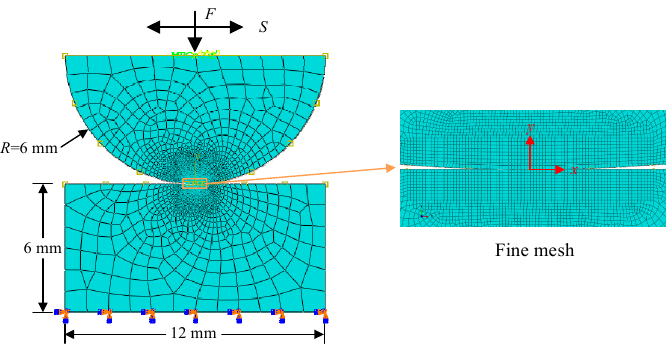
Figure 3. Finite element model of cylinder-on-flat contact.